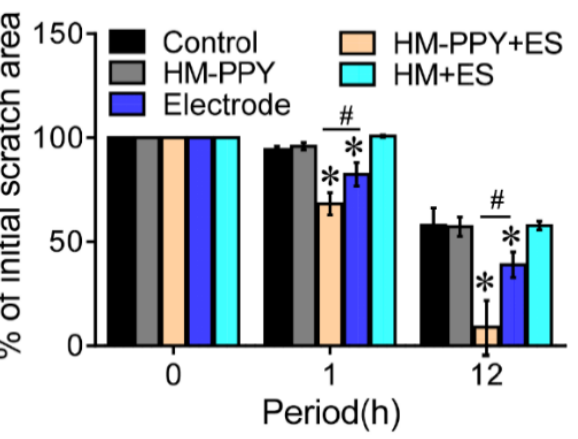
Figure 10. Quantification of % of initial scratch area for the different groups. *Significant difference with the control group ( p = 0.05); # Significant difference between the designated groups ( p < 0.05). Reproduced with permission from [37]. Copyright (2019) Elsevier.